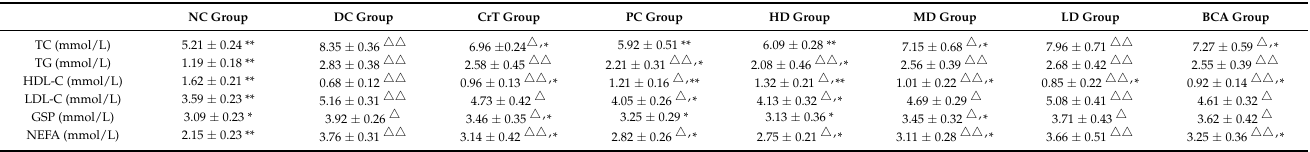
Table 5. Effect of [CrBCA 3 ] on serum biochemical indices in